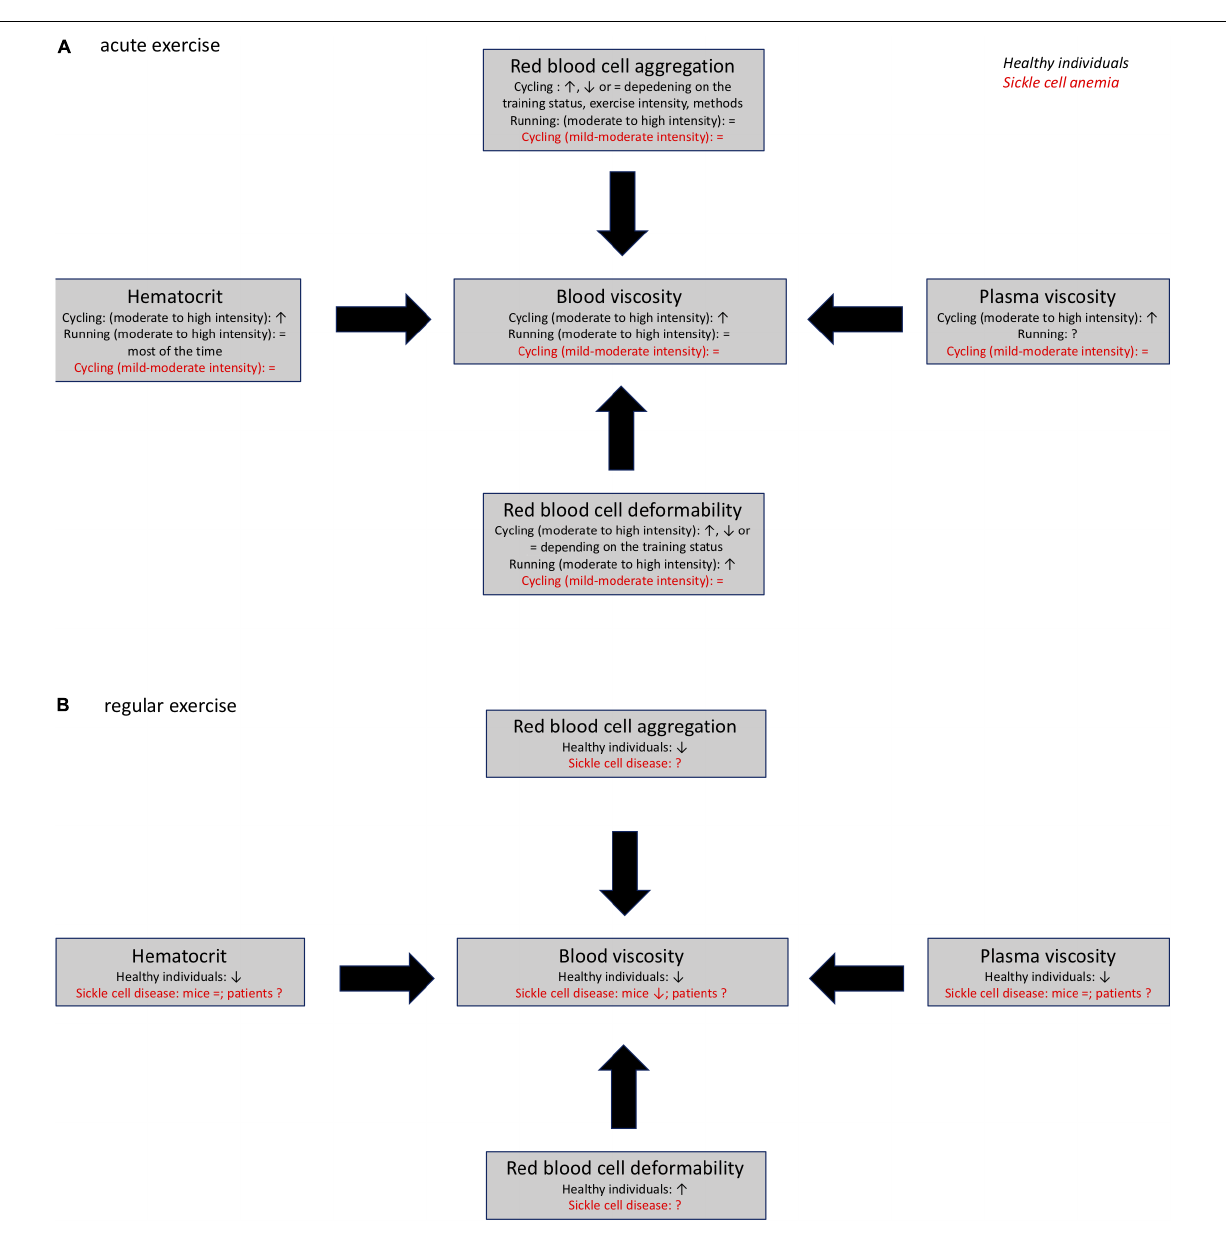
FIGURE 2 | Acute (A) and chronic (B) effects of exercise on blood rheology (blood viscosity, plasma viscosity, hematocrit, red blood cell deformability, and aggregation) in healthy individuals and patients with sickle cell anemia., ↑ , ↓ ; =, no change; ?,